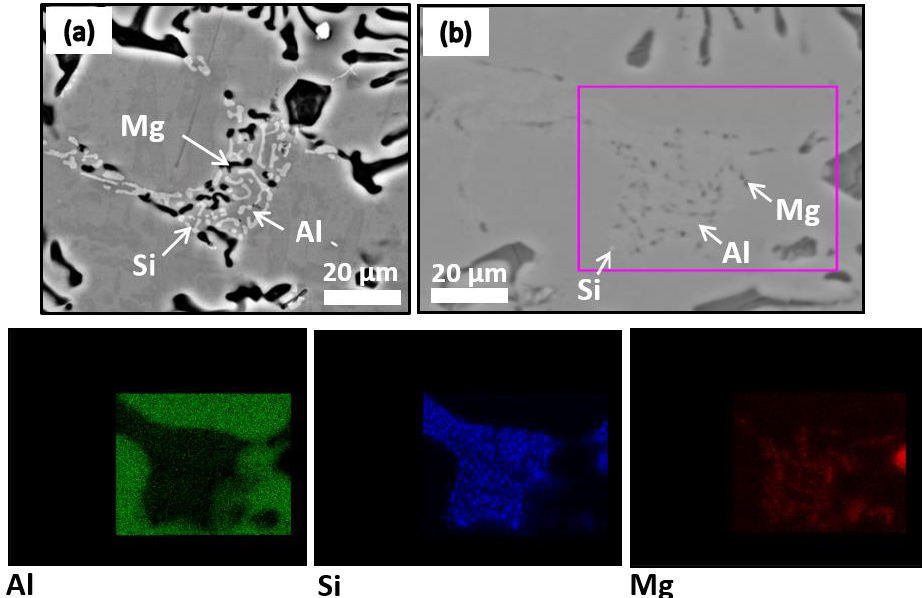
Figure 7. ( a , b ) SEM backscattered (BS) image and corresponding EDS elemental maps from the selected region for the Al-13.1 wt.% Mg 2 Si alloy showing the presence of Al, Mg and Si.